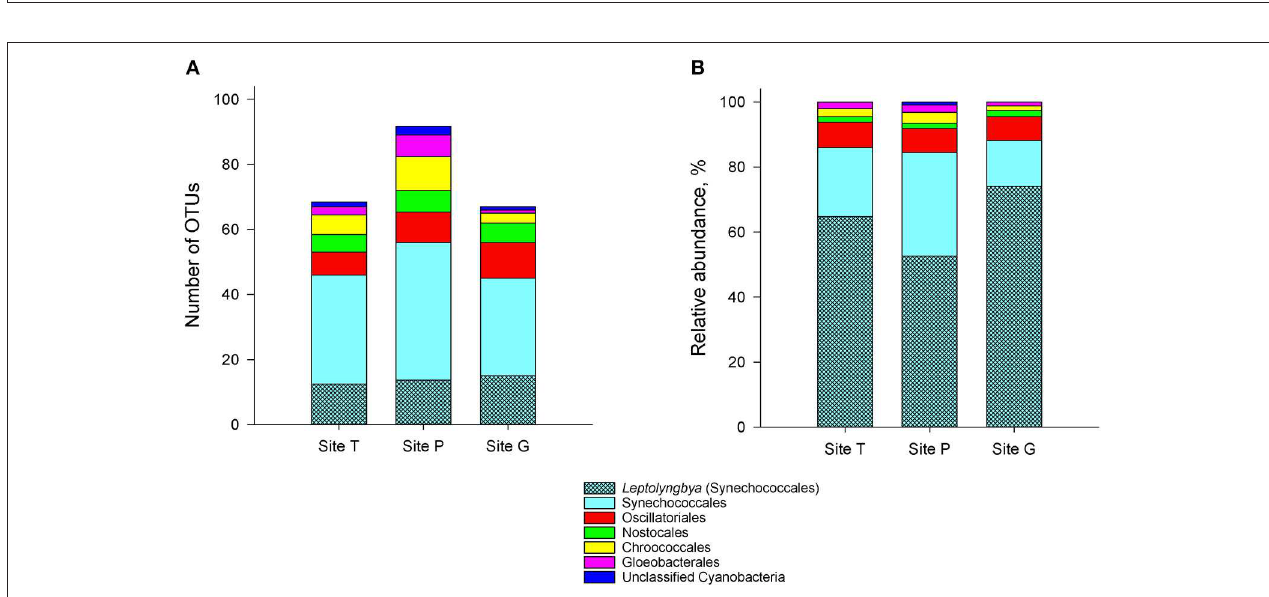
FIGURE 4 | Cyanobacterial community composition in three studied localities based on Illumina sequencing of the 16S rRNA gene. Data were calculated after the normalization to 1983 sequences per sample. (A) Richness expressed as the number of OTUs and (B) distribution of the reads expressed as relative abundance.